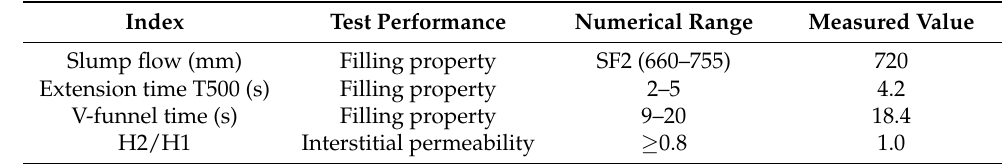
Table 3. Measured and specified values of performance of